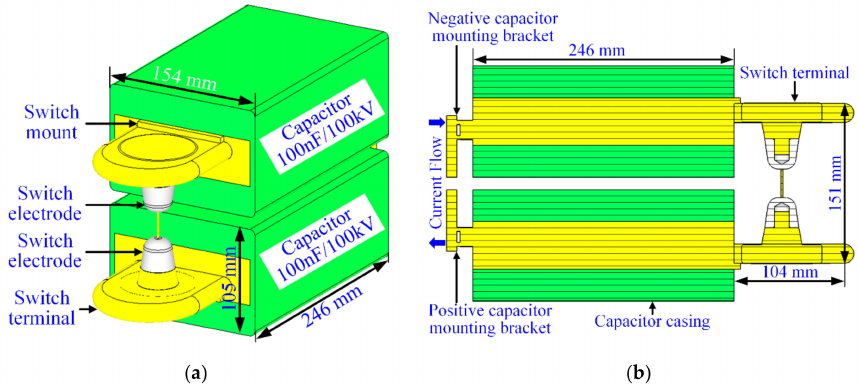
Figure 8. Finial simplified model of the discharge brick. ( a ) Perspective view, ( b ) cut-away